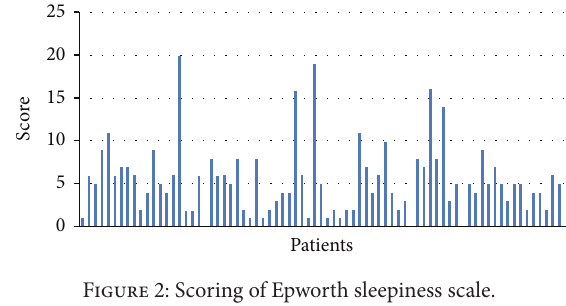
Figure 2: Scoring of Epworth sleepiness scale.